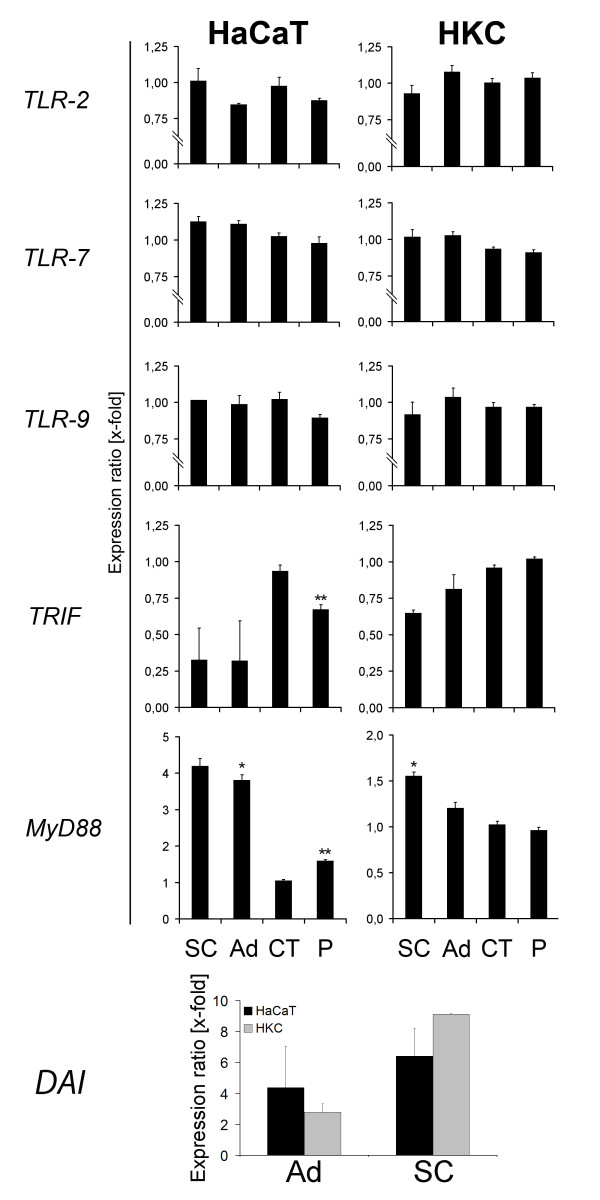
Involvement of Toll-like receptor family in DNA recognition. RT-PCR analysis (45 cycles) for TLR-2, -7, -9, TRIF and MyD88 and DAI expression in HaCaT cells and HKC stimulated with DNA (5 μg DNA/ml medium) from adenovirus (Ad), Saccharomyces cerevisiae (SC), calf thymus (CT) and plasmids (P). Cells were stimulated for 6 h (HKC) and 15 h (HaCaT cells). Data from DAI expression was generated from cells transfected with 5 μg DNA/ml medium. Results were normalised to 18S ribosomal RNA (ratio: target gene/housekeeping gene) and compared to non-treated samples (vehicle control) (* = p < 0.05; ** = p < 0.005 to vehicle control).